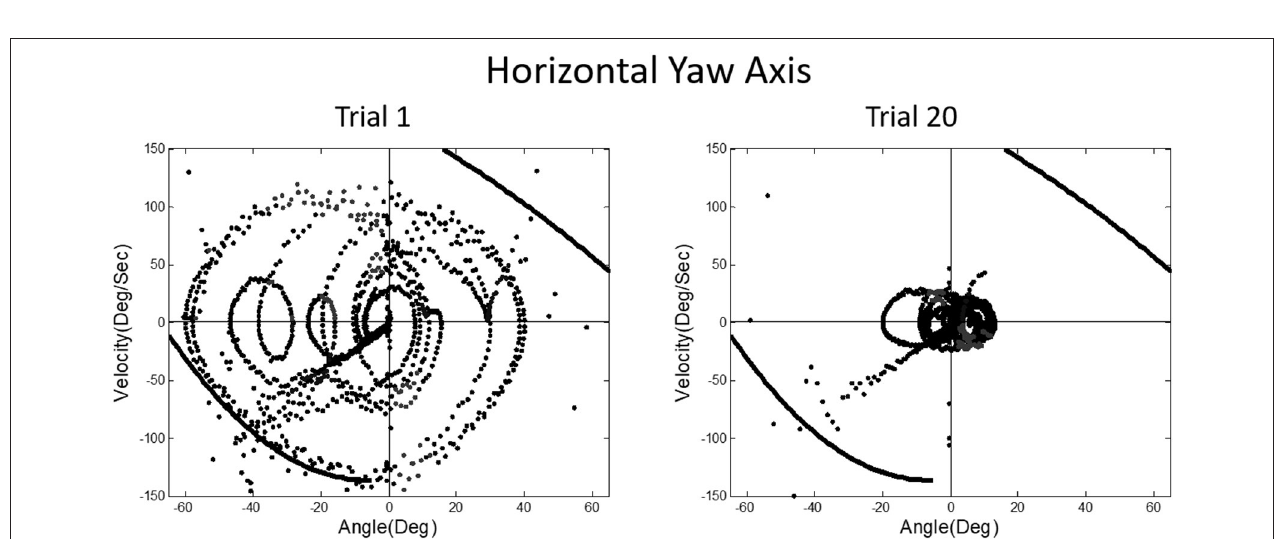
FIGURE 14 | Position-velocity phase plots for a typical subject performing horizontal yaw axis dynamic balancing. In this situation, gravity dependent positional shear forces are present and learning is obvious from Trial 1 to 20, just as in vertical roll plane balancing shown in Figure 11 .